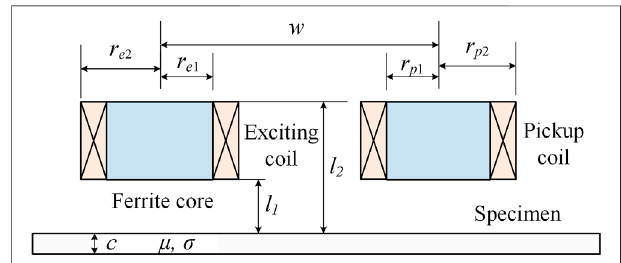
FIGURE 4 | Experimental detection system. FIGURE 5 | Structure of eddy current